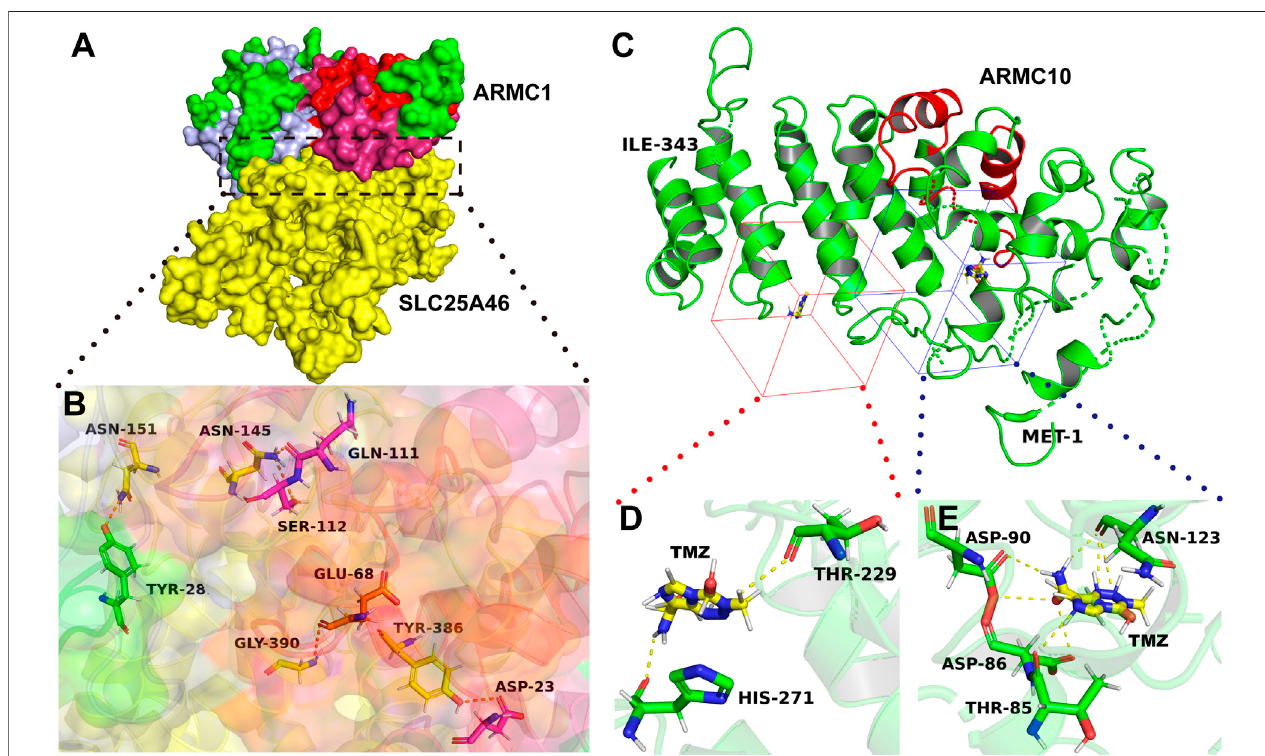
FIGURE 3 | Interaction regions in ARMC proteins. (A) ARMC1 interacts with ALS25A46. The yellow color shows SLC25A46, and the other colors shows ARMC1 proteins: the red color shows the armadillo repeat domain of ARMC1, the pink color shows the domain adjacentto the armadillo repeat domain, which combine to form an α -superhelix, and the light blue color shows the heavy metal-associated domain. (B) Zoomed-in image. Among the fi ve amino acids in ARMC1 that can form polar bondswithSLC25A46,thearmadillorepeatfunctionalregioncontributesfour,ASP-23,GLU-68,GLN-111,andSER-112.Thepinksticksshowtheaminoacidsin thepinkregion;theyellowsticksshowtheaminoacidintheyellow region;theorangesticksshowtheaminoacidintheredregion;thegreenstickshowstheaminoacid inthegreenregion;blue:Natom,red:Oatom. (C) ARMC10interactswithTMZ.TheN-terminusisshownasMET-1,whereastheC-terminusisshownasanotheramino acid. The red cartoon represents the armadillo repeat domain. The red and blue cubes show the ligand-binding pockets of ARMC10. (D,E) Zoomed-in image. Green: C atom, red: O atom, blue: N-atom. The structures (homology models) of ARMC1, SLC25A46, and ARMC10 were generated using Phyre2 (Kelley et al., 2015), and the structure (crystal model) of TMZ were obtained from The Cambridge Crystallographic Data Centre (CCDC Number: 665060, CSD Entry: DIPGIS11). The pictures were generated using PyMOL (Schrodingerhe LLC) and PlayMolecule